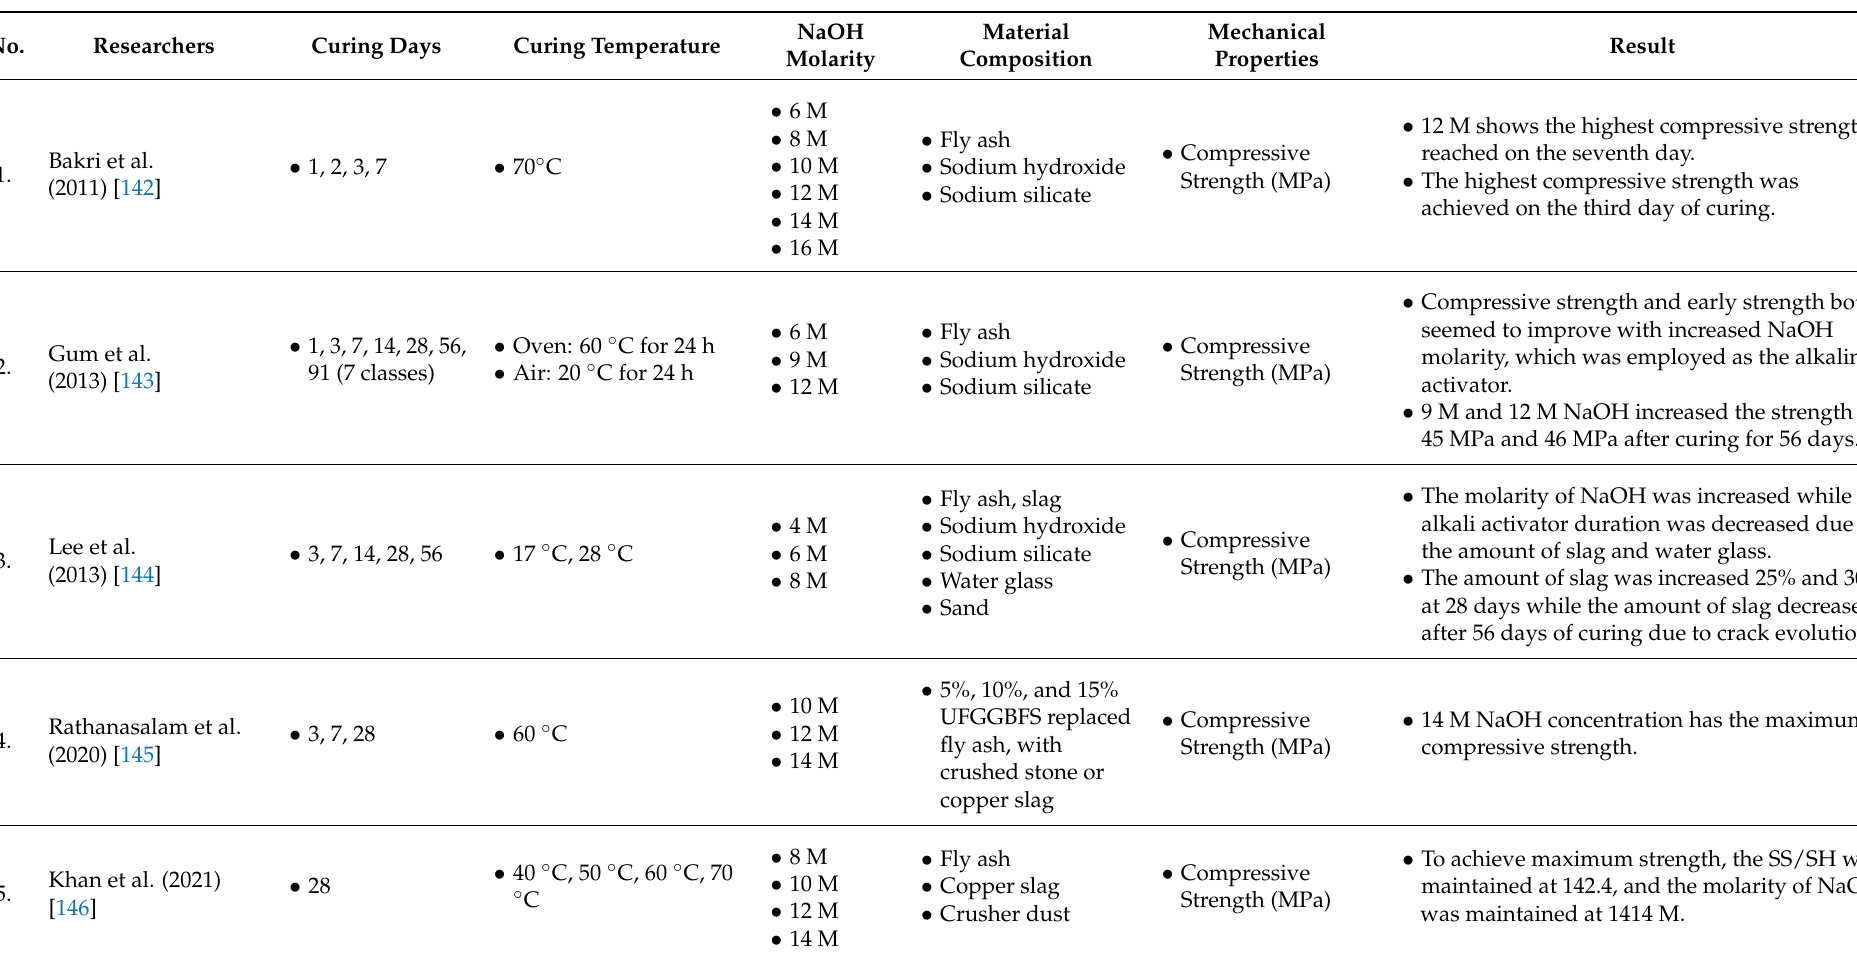
Table 9. Research on the effect of the molarity of NaOH on mechanical